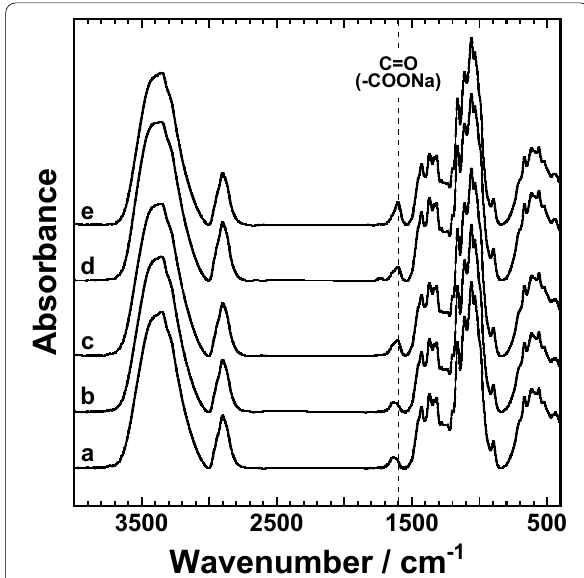
Fig. 3 FT-IR spectra of cellulose nanofibrils derivatized through carboxymethylation after alkali-activation with different NaOH concentrations. NaOH concentrations: a 0.0 wt%, b 1.0 wt%, c 3.0 wt%, d 5.0 wt% and e 7.0 wt%, corresponding to Fig. 1b